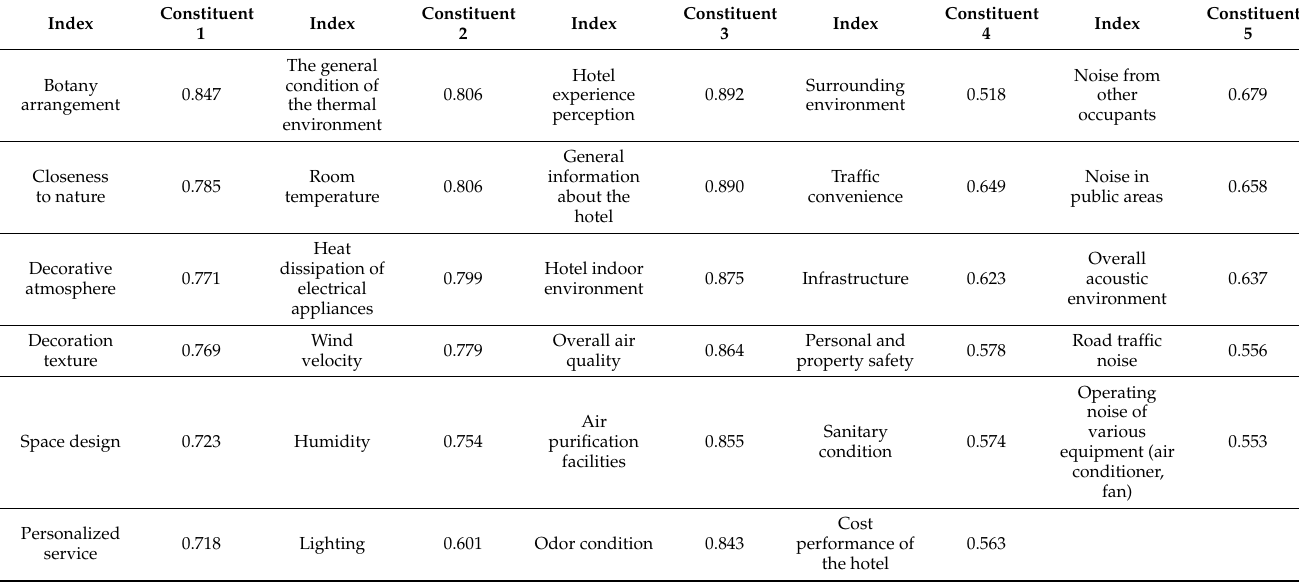
Table 5. Index and proportion of each component after rotation.